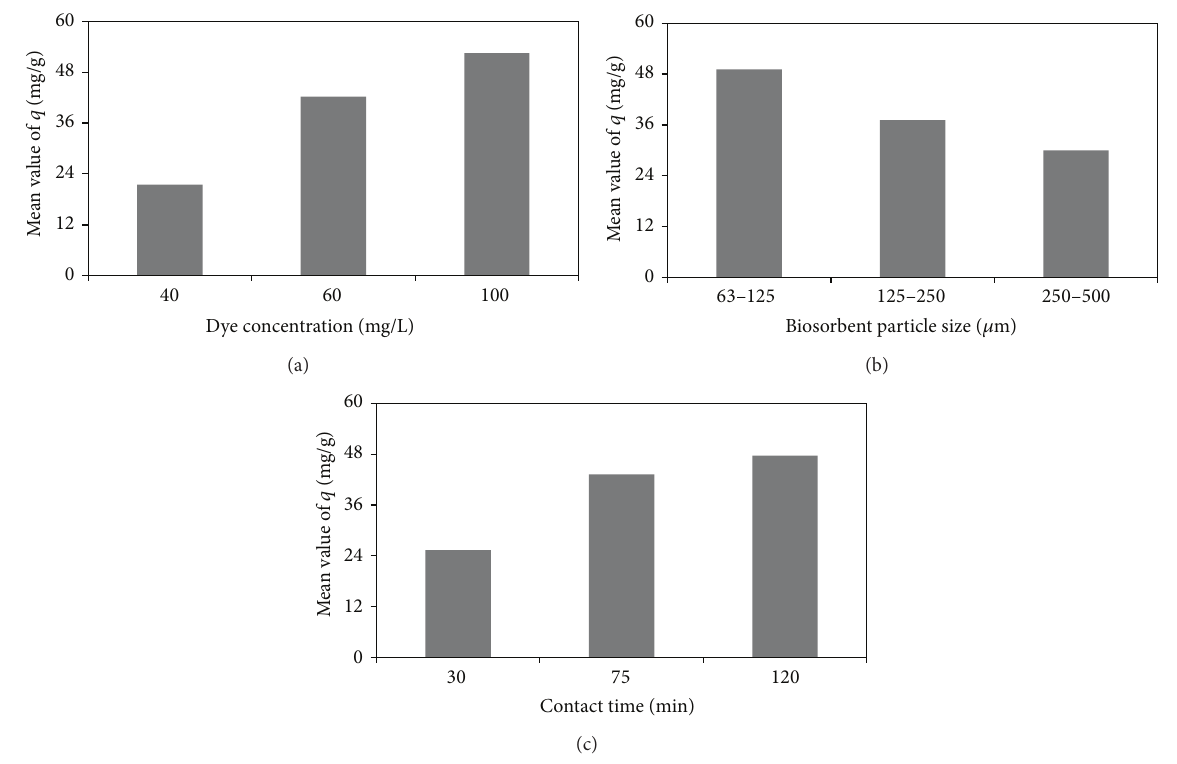
Figure 3: Effect of each factor studied on biosorption of dye.